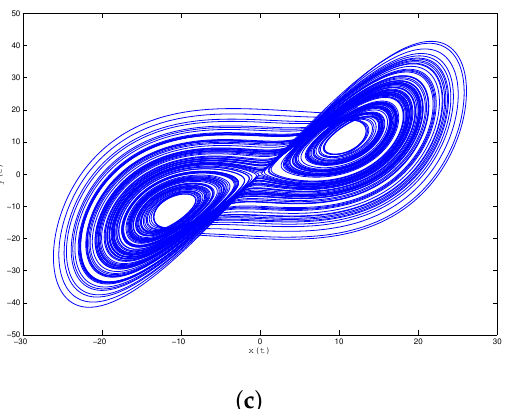
Figure 1. Chaotic State trajectories of the fractional-order Chen system: ( a ) states z - y ; ( b ) states z - x ; and ( c ) states y - x